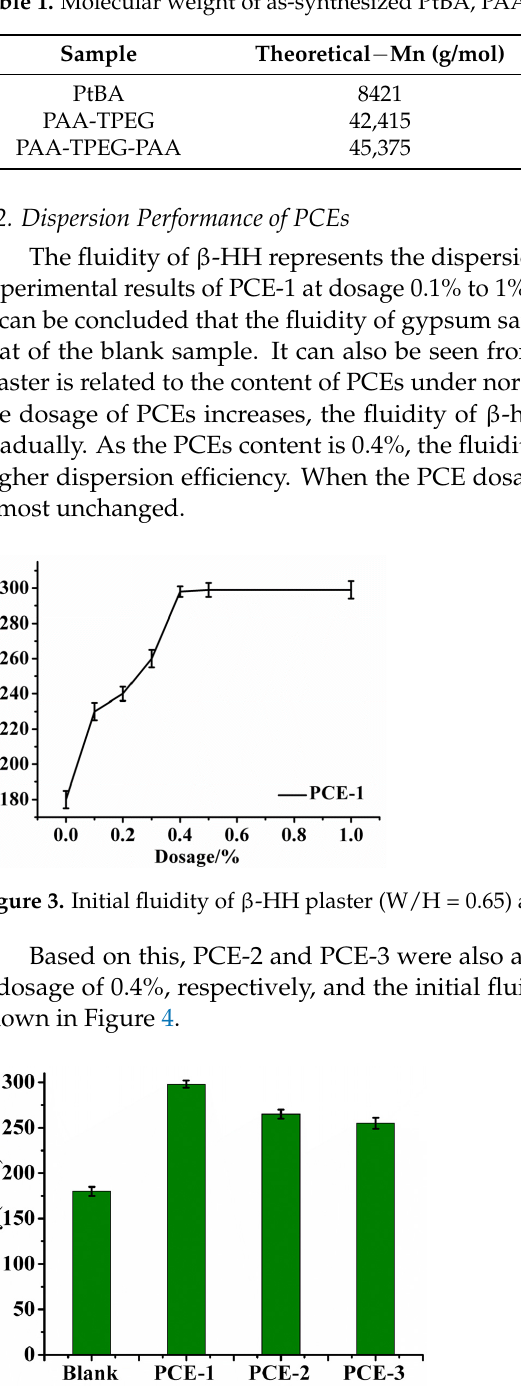
Table 1. Molecular weight of as-synthesized PtBA, PAA-PTPEG, and PAA-PTPEG-PAA.